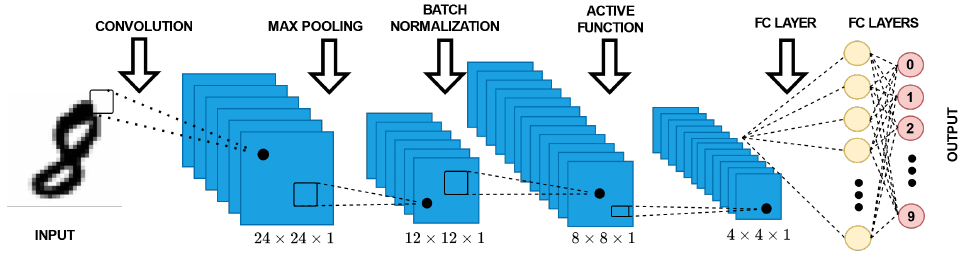
Figure 1. Architecture of a CNN.